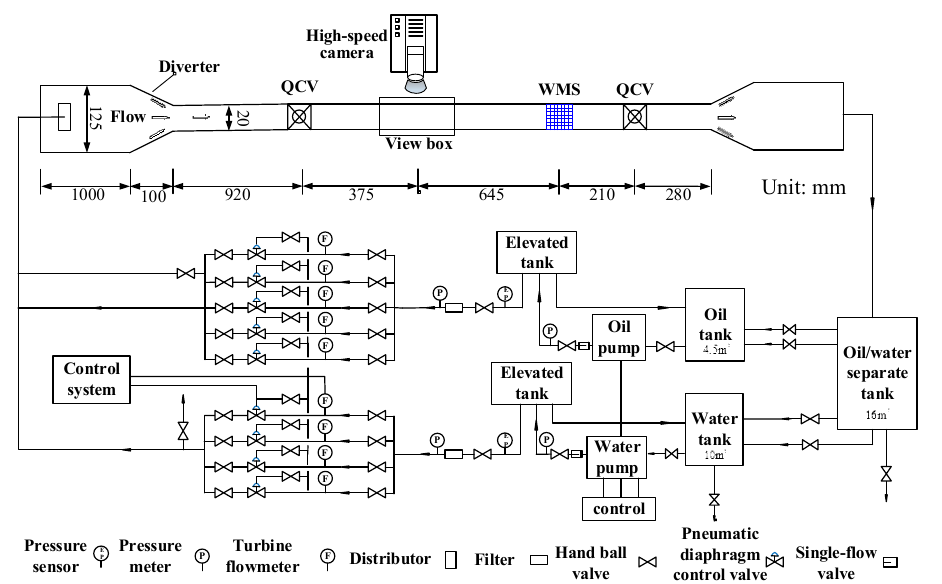
Figure 4. Schematic of the experimental setup for horizontal and inclined oil–water two ‐ phase flows.